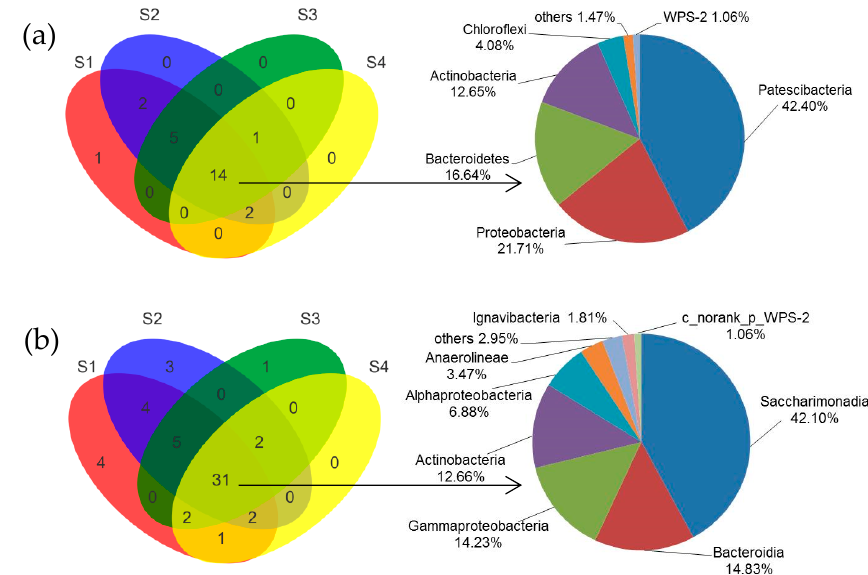
Figure 6. Venn of microbial communities from S1–S4 at the phylum ( a ) and class ( b ) level.